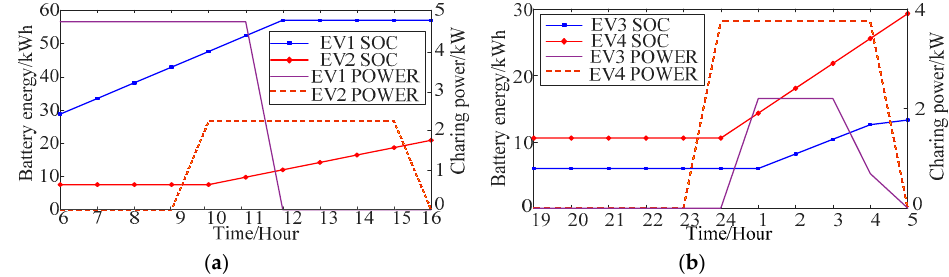
Figure 9. Charging profiles of EVs connected to facilities at different buses: ( a ) Charging profiles of EV type-I and type-II parked at bus 31; ( b ) charging profiles of EV type-III and type-IV parked at bus 107. 6. Conclusions To evaluate the impact of charging stations changed from gas stations in the oil-to-electricity transformation for automobiles, a mapping relation model between gas stations and charging stations serving vehicles in the same region was established by using membership degree function of EV and queuing model-based charging stations. A novel feature of the proposed EV charging stations was that the real-time data of gas stations and parking lots serving the regional automobiles was used to determine the stochastic EV charging time and charging demand distribution in the power network. Therefore, the controllability of EV charging load can be quantified by integrating the EV charging process with parameters and control variables in the optimal dispatch of the distribution